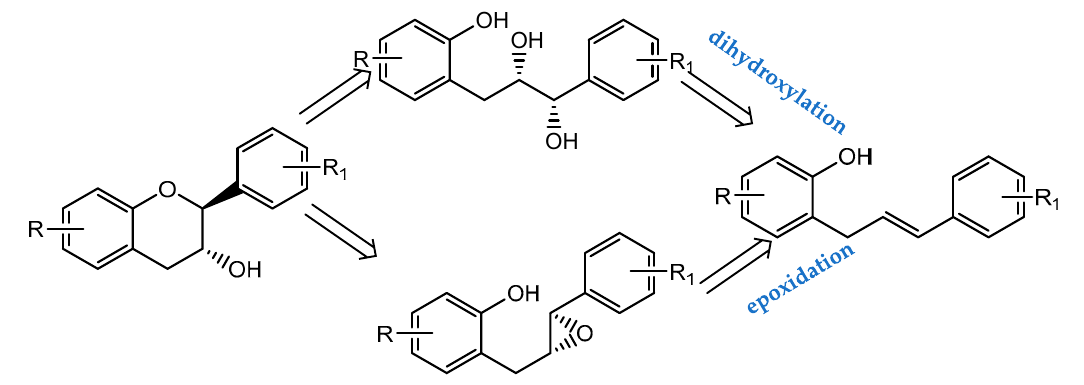
Figure 17. Dihydroxylation and epoxidation to construct chiral centers (Retrosynthesis). Asymmetric dihydroxylation of olefins with AD-mix- α or AD-mix- β catalyst create syn -diols with good yields and optical purity (Figure 18) [150]. In this way, two stereogenic centers were obtained in a single reaction step that make this reaction very effective. However, the hydroxyl of the phenol group from the starting reagent needed to be protected with groups such as methoxymethyl (MOM), t -butyldimethylsilyl or benzyl (Bn) before asymmetric dihydroxylation [151]. Then, the chiral diols by cyclization and deprotection formed the respective flavanols [149].